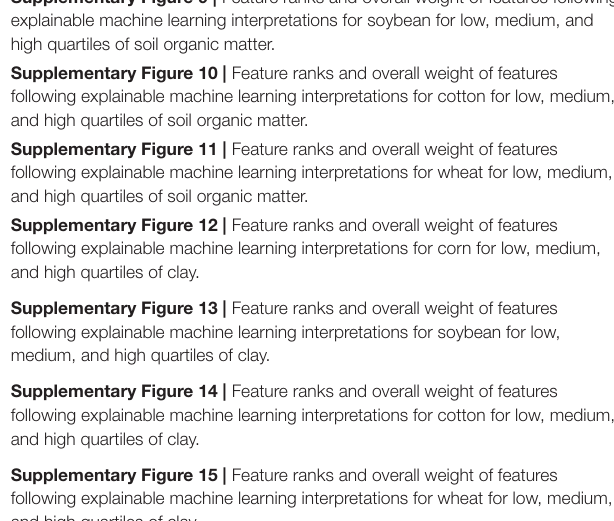
Supplementary Figure 2 | Histograms of climate factors in the ACDC (Agro Climatic Data by County) dataset. Supplementary Figure 3 | Histograms of soil properties in the ACDC (Agro Climatic Data by County) dataset. Supplementary Figure 4 | Correlation matrices between soil properties and climate factors and yields of corn in the ACDC (Agro Climatic Data by County)